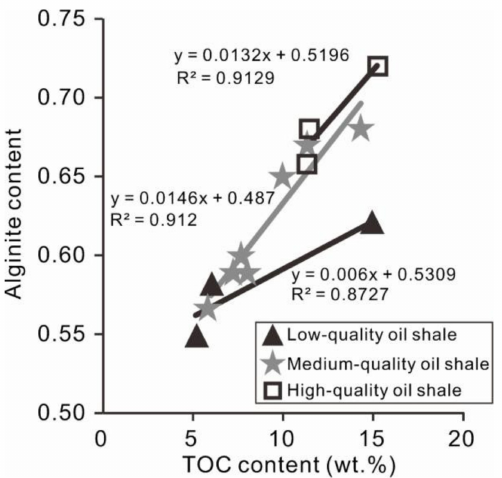
Figure 9. Correlations of total organic carbon (TOC) content and alginite content for the different quality oil shales in the Shale Member of the Shimengou Formation.